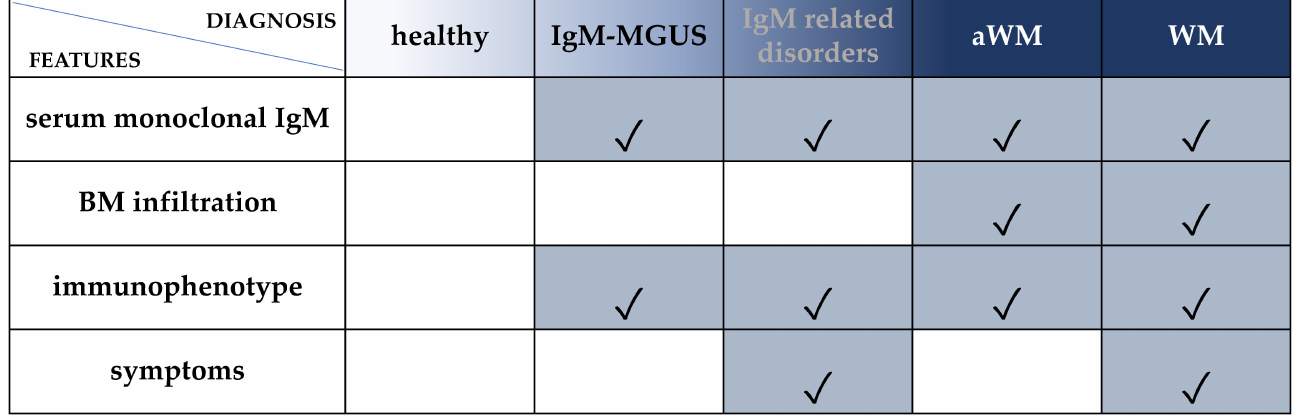
Figure 1. Diagnostic criteria for WM and IgM-MGUS. Serum monoclonal IgM: any